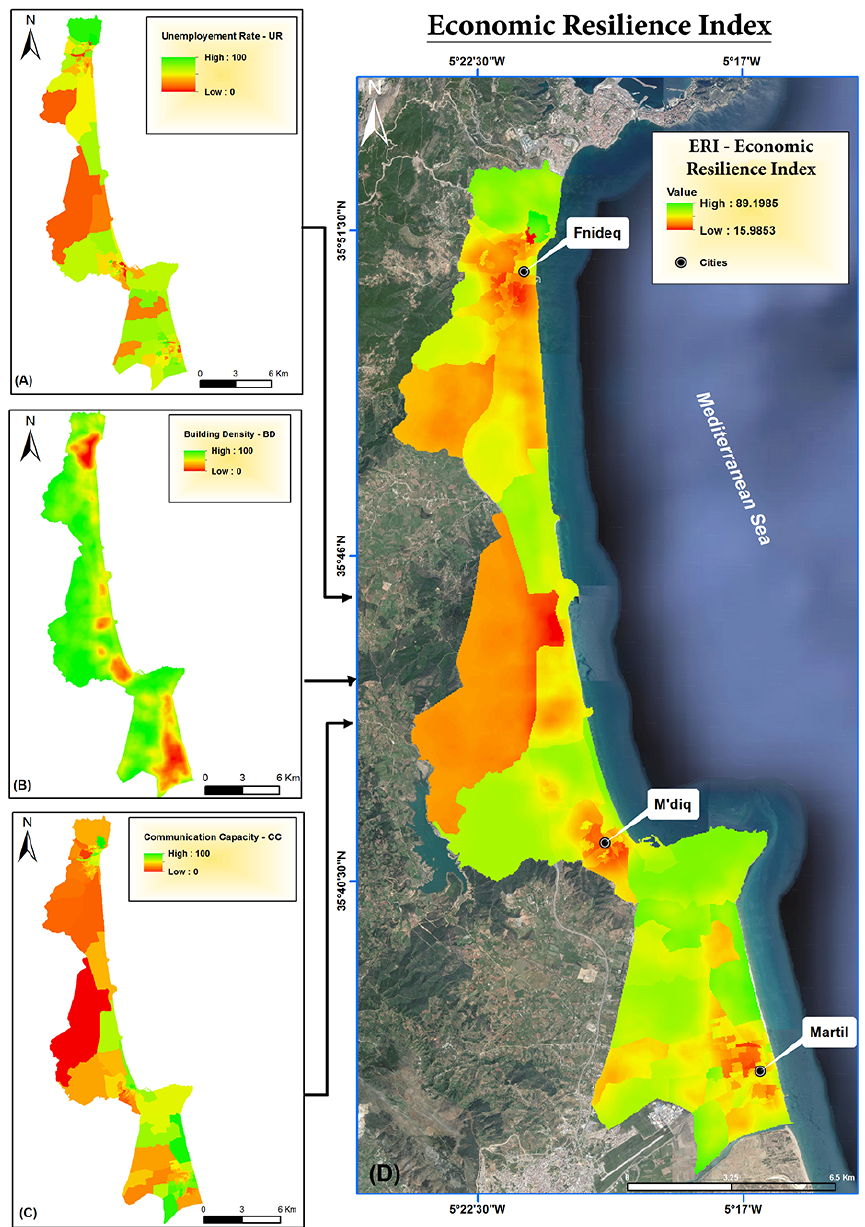
Figure 5. Spatial distribution of (a) unemployment rate, (b) building density in 2017, (c) communication capacity, and (d) economic- resilience index (obtained from © Google Maps